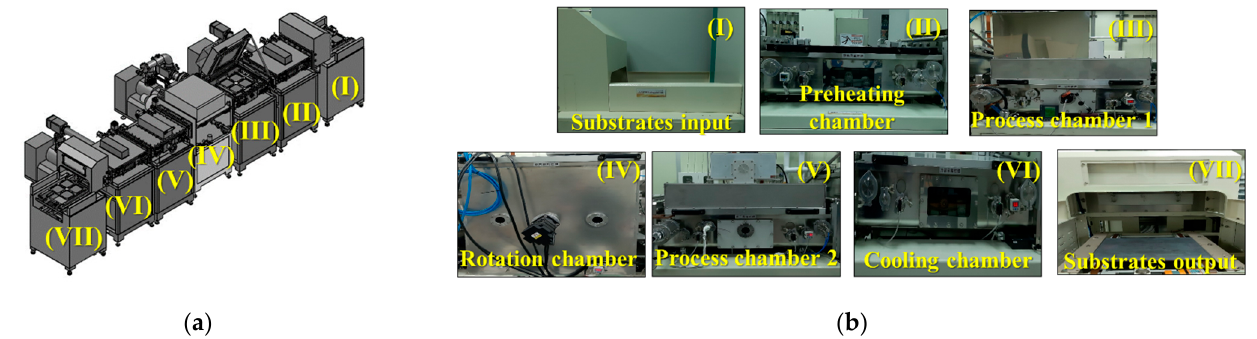
Figure 2. The use of the in-line 40.68 MHz VHFPECVD in this study: ( a ) equipment diagram; ( b ) entity diagram. ( I ) The substrates input; ( II ) the preheating chamber; ( III ) process chamber 1 for depositing the nc-Si:H; ( IV ) the rotation chamber for depositing the thin film on the back of the substrate; ( V ) process chamber 2 for depositing the nc-Si:H on the back of substrates; ( VI ) the cooling chamber; and ( VII ) the substrate output.